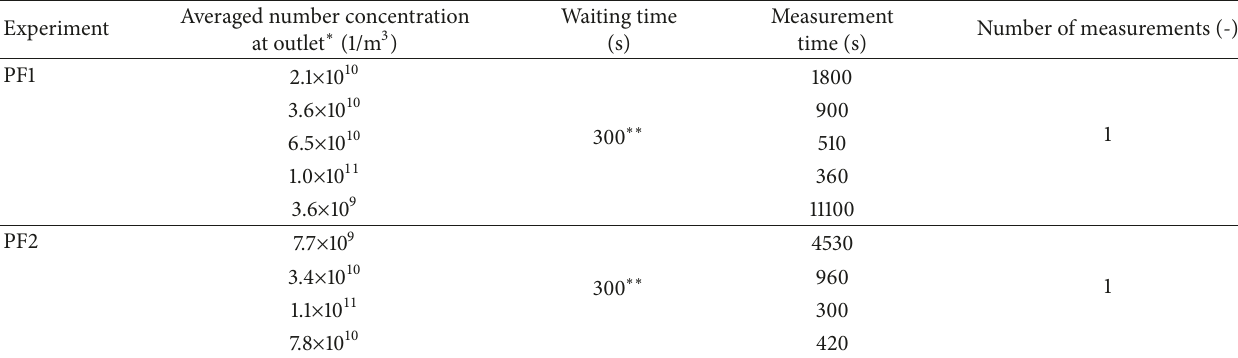
Table 3: Aerosol measurement information of the experiments PF1 and PF2.